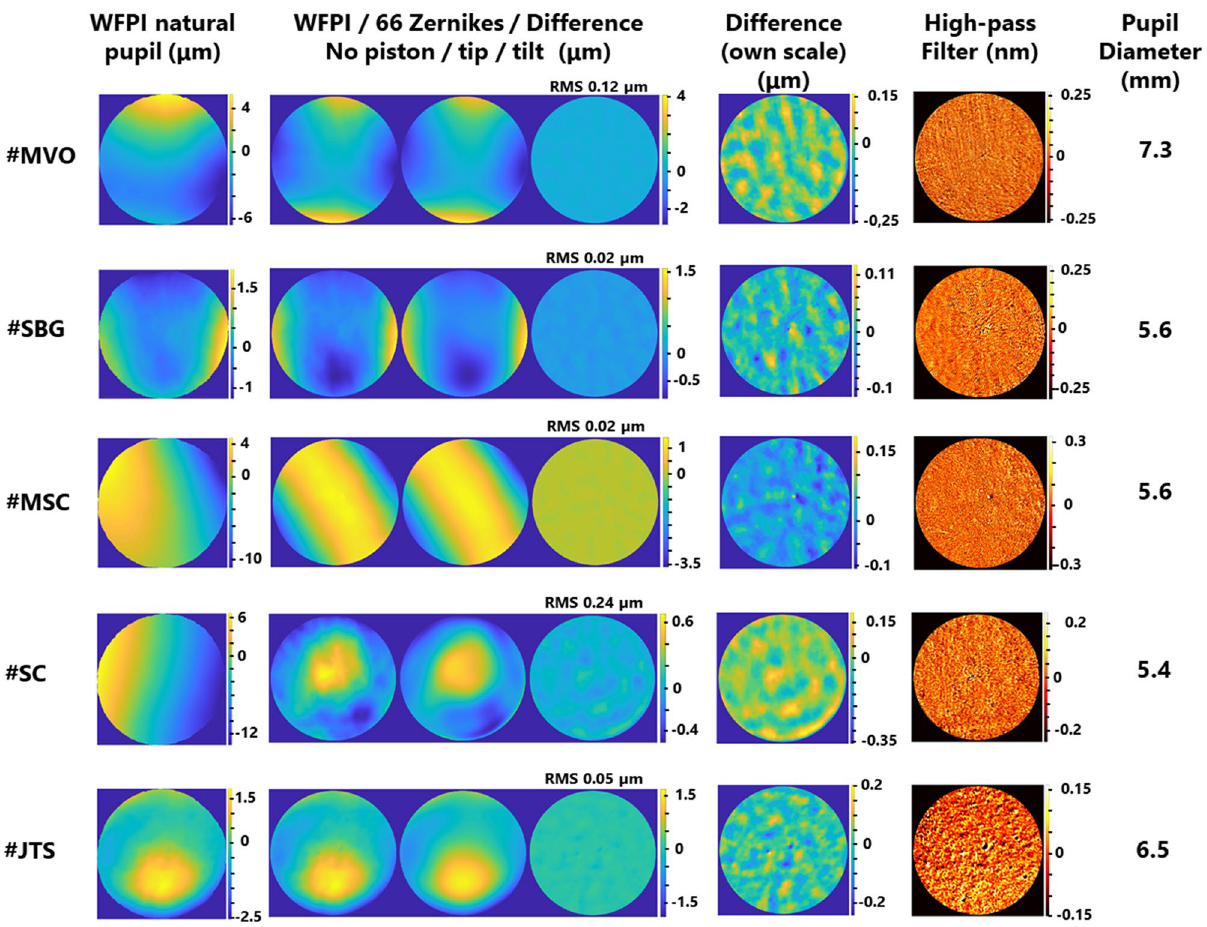
Figure 6. Measurements of 5 real eyes (the same as in Fig. 5) with the device and its analysis with a lateral resolution of 8.55 µm. The first column is the phase map retrieved by the apparatus. The second column is a group of 3 sub-images comprising the WFPI result within a circular pupil and without piston/tip/tilt, its fit to the first 66 Zernike polynomials, and the difference between the two. The third column is the same difference phase map as above but with its own colour map or scale. The fourth column is the first phase map of the second column, to which a Gaussian filter with sigma = 0.5 was applied, thus revealing the high-frequency components of the phase. Finally, the last column indicates the diameter of the pupil when considering a circular pupil (the largest inscribed